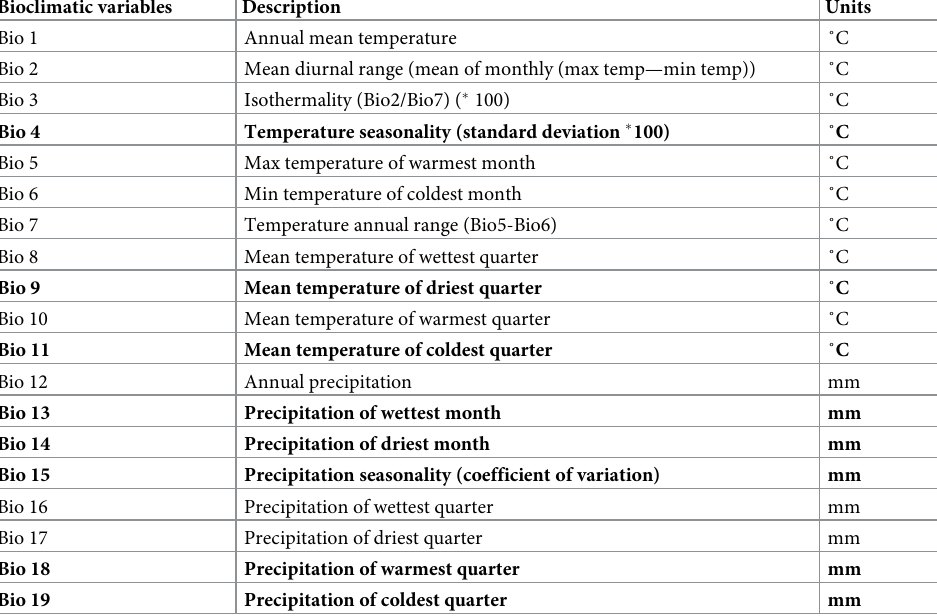
Table 1. Worldclim bioclimatic variables used as potential predictor variables in the MaxEnt models [56]. The variables in bold were used in the final models of Bactrocera zonata’ climatic suitability after eliminating the highly cor- related